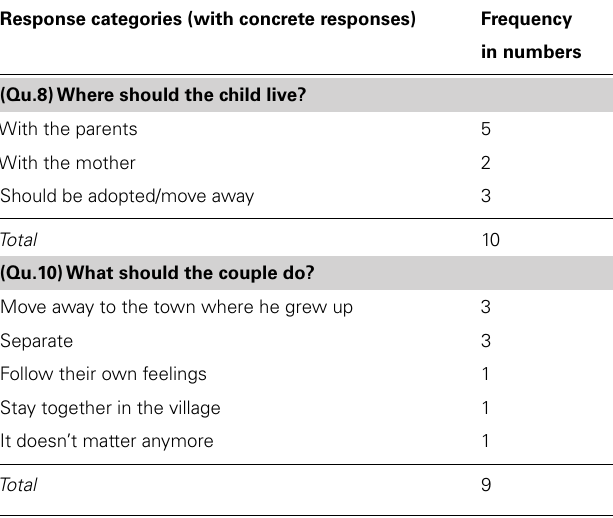
Table 5 | Responses on practical consequences of moral evaluations (cluster III). Response categories (with concrete